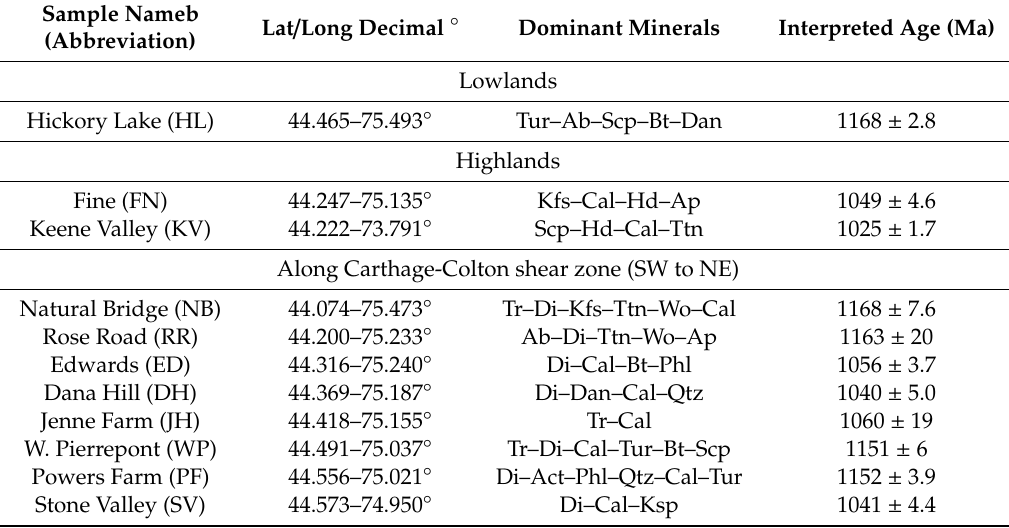
Table 1. U–Pb zircon sample locations, dominant mineralogy, and U–Pb zircon